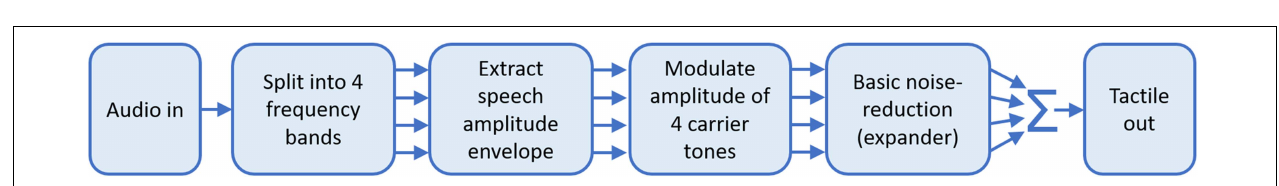
FIGURE 1 | Number of publications each year from 1970 to 2020. Data taken from Google Scholar searches for articles (including patents, not including citations) with the term "tactile aid" (shown in blue) or "cochlear implant" (shown in red) in the title. The search was conducted on 07/02/2021.